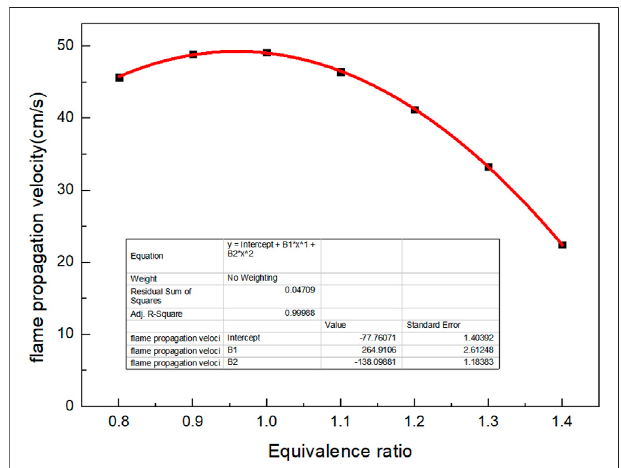
FIGURE 6 | Graph of fl ame combustion temperature versus fl ame distance with variation of Φ . FIGURE 7 | Curve of